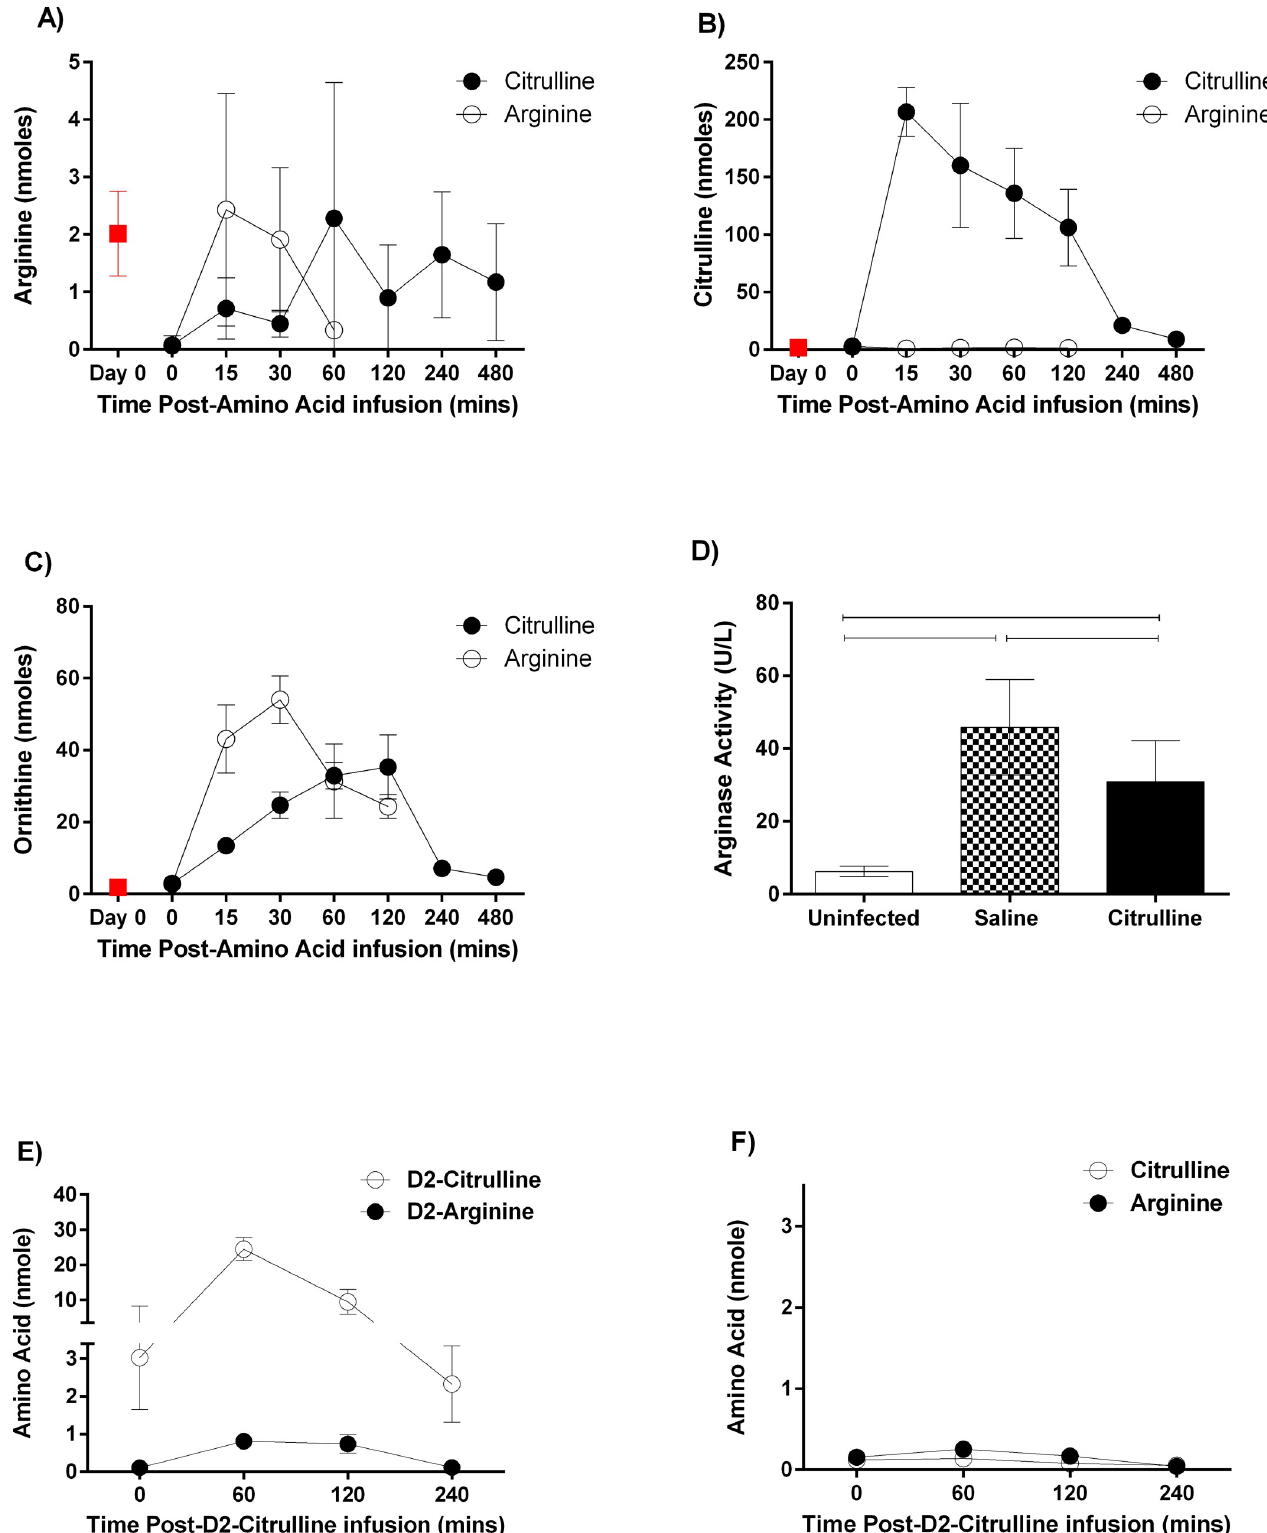
Fig 1. Citrulline is converted to arginine on day 5 of eCM restoring plasma arginine levels to uninfected levels. Mice were injected i.v. with PbA on day 0 PI. A-C: On day 5PI (just prior to eCM on day 6PI), mice were injected ip with equimolar citrulline or arginine (430 mM) at time 0 and then plasma from n = 3